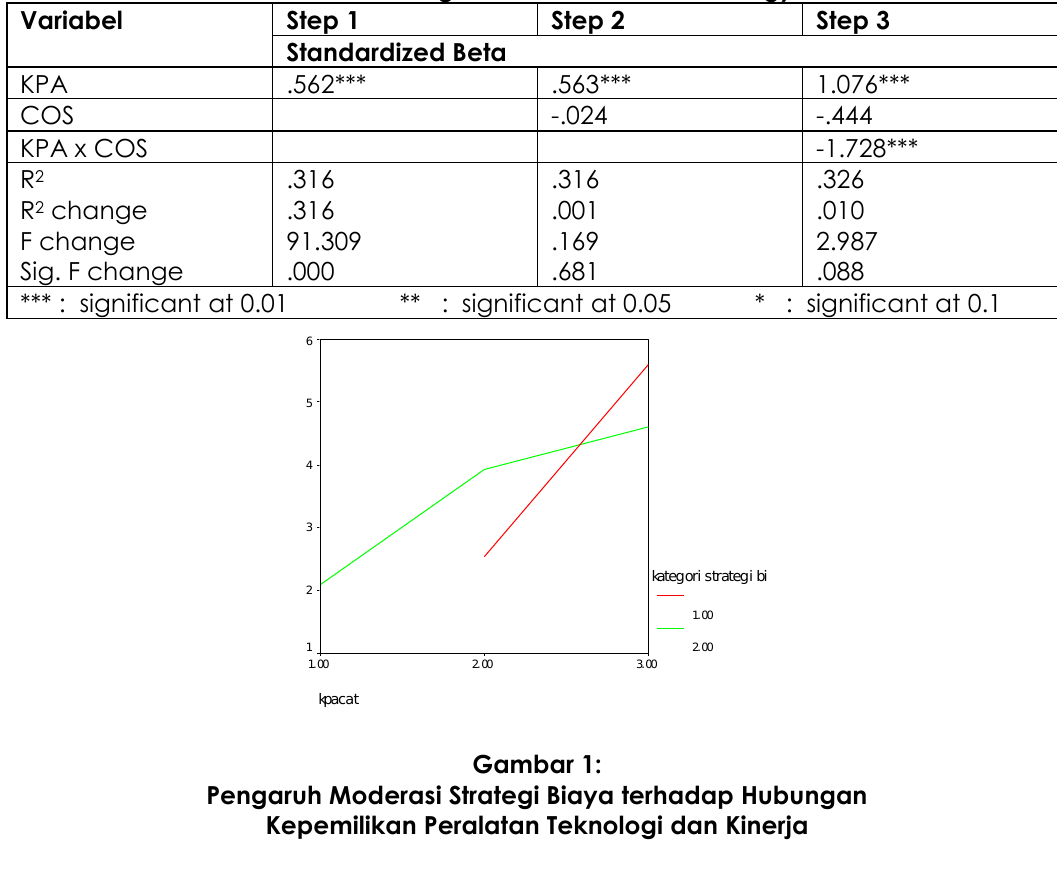
Table 10: Pengaruh Moderasi Cost